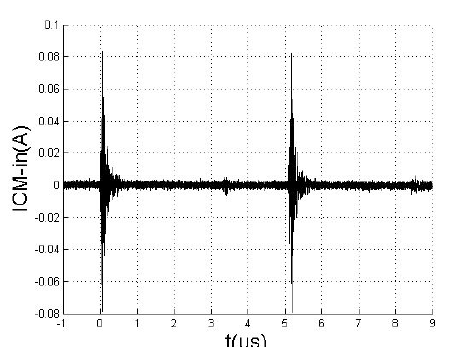
Figure 23: Experimental waveform of the current i